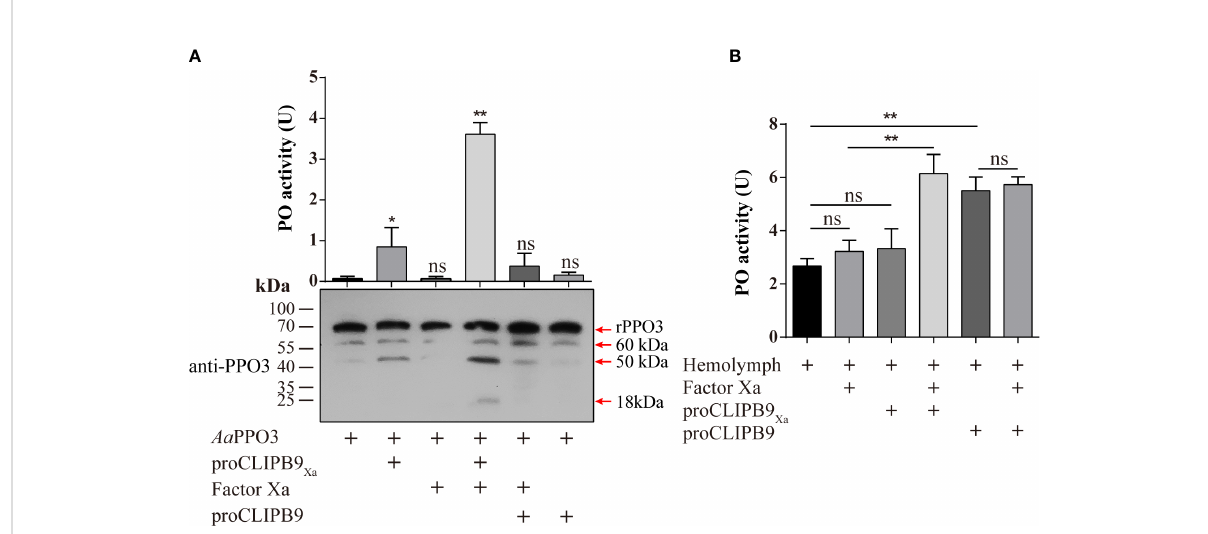
FIGURE 3 Cleavage activation of Ae. aegypti PPO3 by Factor Xa-treated proCLIPB9 Xa. (A) PPO3 was activated by CLIPB9. Recombinant PPO3 was incubated with buffer, Factor Xa, proCLIPB9, proCLIPB9 Xa , or Factor Xa and proCLIPB9/proCLIPB9 Xa . The mixtures containing 300 ng PPO3 were used in the PO activity assay (upper panel), and the mixtures containing 100 ng PPO3 were analyzed by immunoblotting using PPO3 antibodies (bottom panel). (B) CLIPB9 activates PPO in hemolymph. The 1:10 diluted hemolymph samples were incubated with proCLIPB9 or Factor Xa-treated proCLIPB9Xa. PO activities were measured using dopamine as a substrate and plotted as mean ± SEM (n = 3). **P < 0.01; *P < 0.05; ns, P >